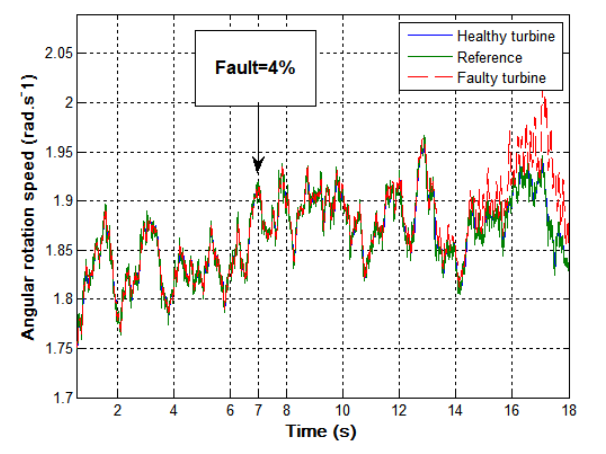
Figure 4. Comparison between angular speeds of the healthy and the faulty machines before the AFTC.